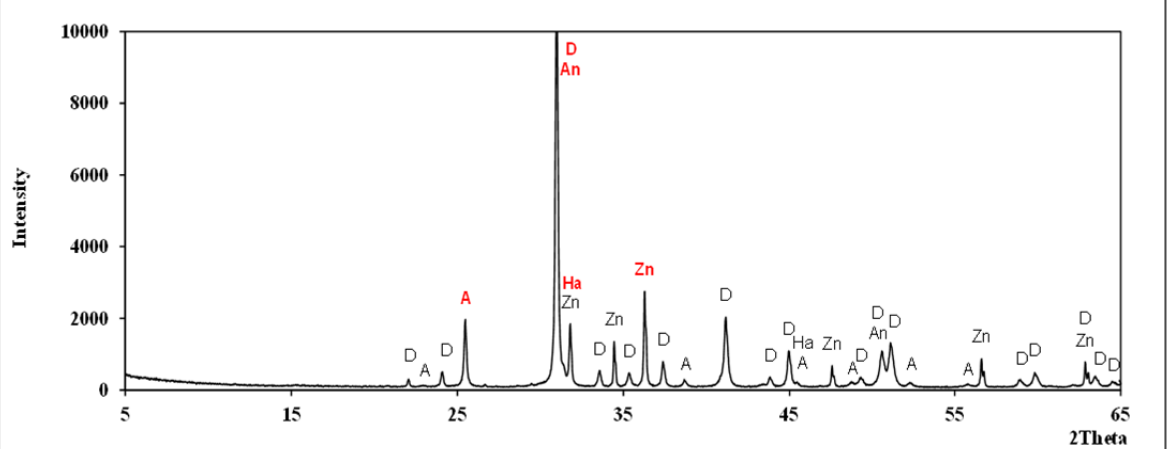
Figure 2. Results of mineral composition analysis of core material from injection well (D — dolomite, A — anhydrite, An — ankerite, Ha — halite, Zn — zincite — reference material). Mineralogical analysis showed that the main component of reservoir rocks is dolo- mite (74.6%), whereas the other components are anhydrite (13.1%) and ankerite (11.3%), calcium and iron carbonate with the formula CaFe(CO 3 ) 2 and a slight addition of halite (1.0%).